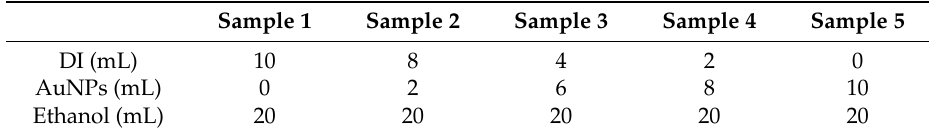
Table 1. Configuration of precursor solvents to